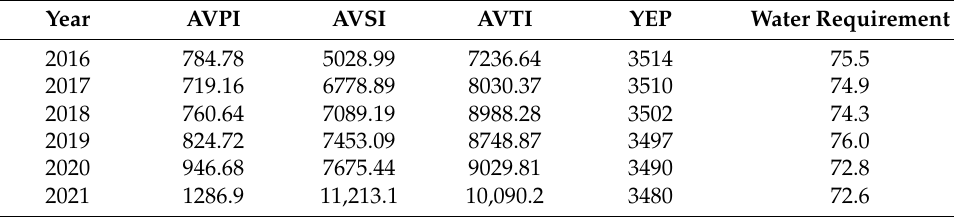
Table 5. The related data in Shanxi Province.